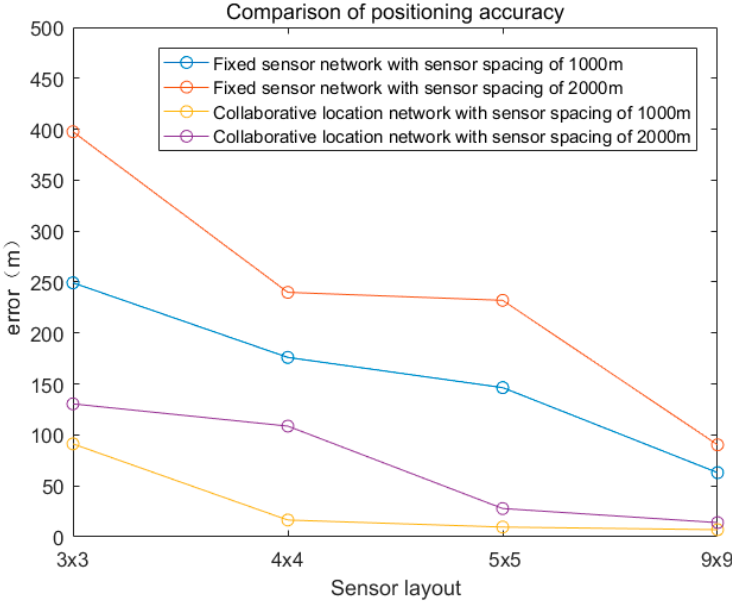
Figure 12. Comparison of positioning accuracy between the fixed sensor network and collaborative location network.